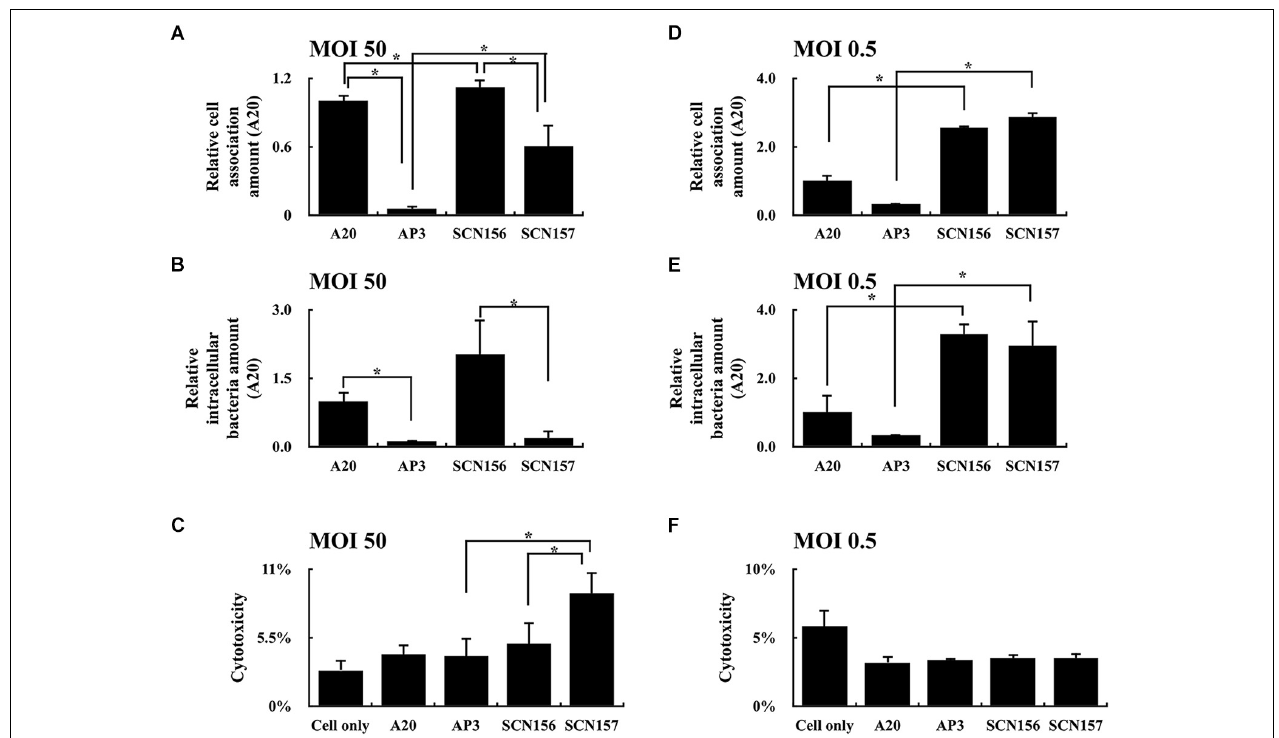
FIGURE 1 | Cell-association and intracellular survival amount of wild-type A20 strain, animal-passage covS mutant AP3, and their capsule-deficient mutants (SCN156 and SCN157, respectively) in PMA-activated U937 cells. (A,D) Cell-association amount of A20, AP3, SCN156, and SCN157 with U937 cells. PMA-activated U937 cells were infected with the IgG-opsonized GAS strains at multiplicity of infection (MOI) of 50 or 0.5 for 30 min. The infected cells were washed after infection, and the number of cell-associated bacteria was determined using plating method. (B,E) Intracellular survival amount of A20, AP3, SCN156, and SCN157 with U937 cells. PMA-activated U937 cells were infected with the IgG-opsonized GAS strains at MOI of 50 or 0.5 for 30 min. The infected cells were washed after infection and incubated in gentamicin-containing medium for 45 min. After gentamicin treatment, the infected cells were washed, and the number of intracellular bacteria was determined using plating method. (C,F) Cytotoxicity of A20, AP3, SCN156, and SCN157 to U937 cells. PMA-activated U937 cells were infected with the IgG-opsonized bacteria at MOI of 50 or 0.5 for 45 min, and culture supernatants were collected for evaluating the cytotoxicity by lactic dehydrogenase (LDH) assay. Error bars represent the standard deviations. ∗ p <